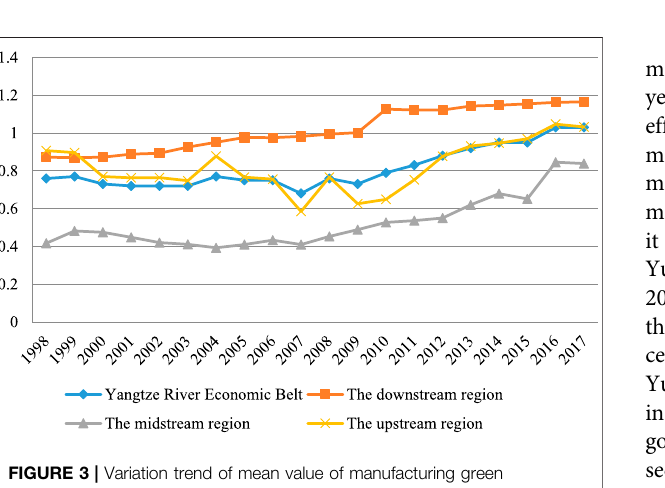
Frontiers in Environmental Science |